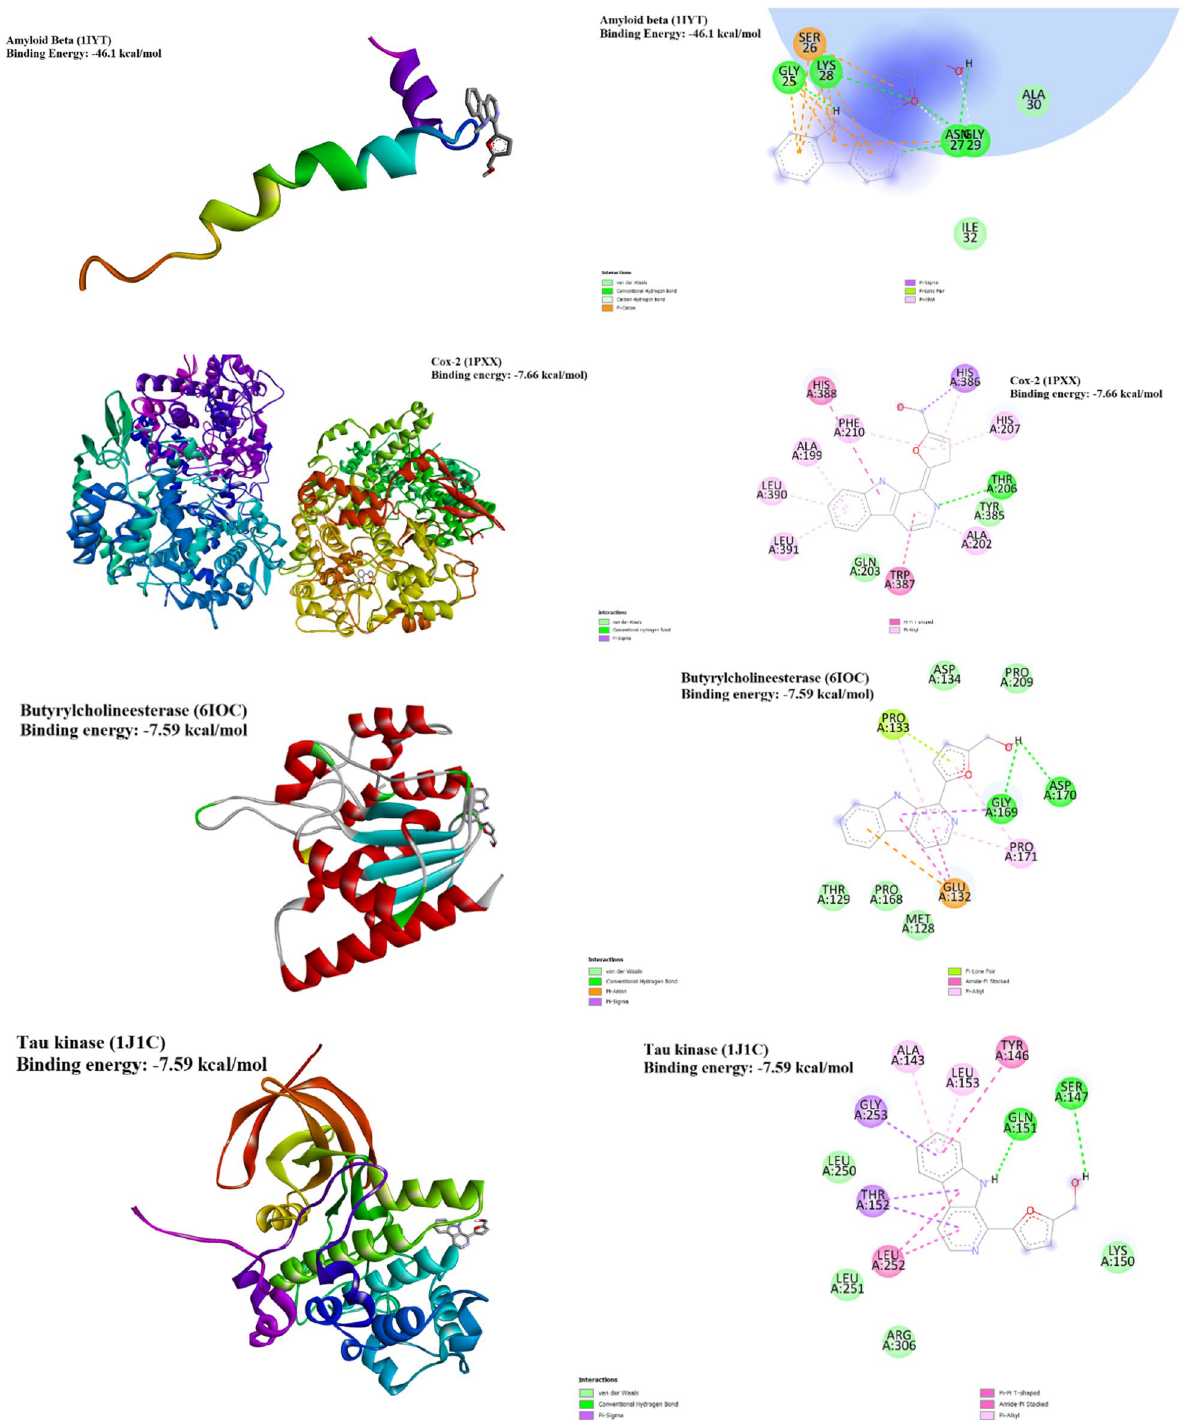
Fig. 8 Docking of perlolyrine with various receptors in Alzheimer’s disease associated with oxidative